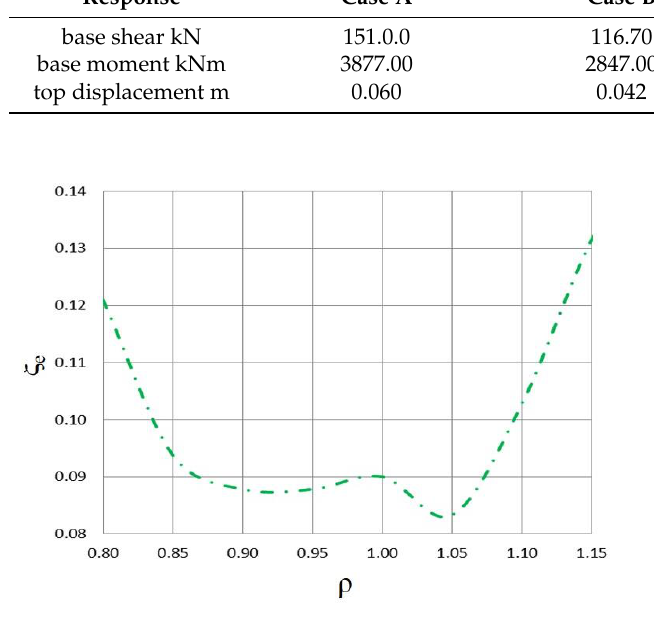
Figure 15. Equivalent damping ratio.